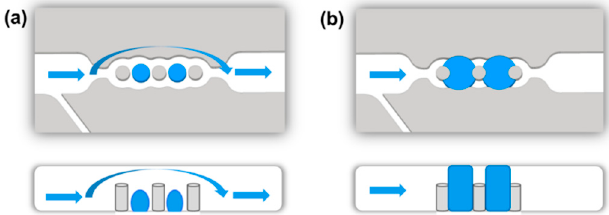
Figure 1. Concept of a hydrogel microvalve in a microfluidic channel in top view ( top ) and side view ( bottom ) with blue arrows symbolizing the fluid flow. ( a ) In the shrunken state, the hydrogel does not block the microfluidic channel and the valve is opened. ( b ) The swollen hydrogel fully blocks the microfluidic channel and impedes the fluid flow. Thus, the valve is closed.